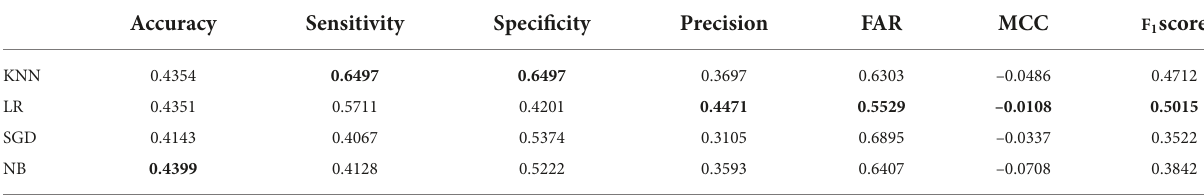
Accuracy Sensitivity